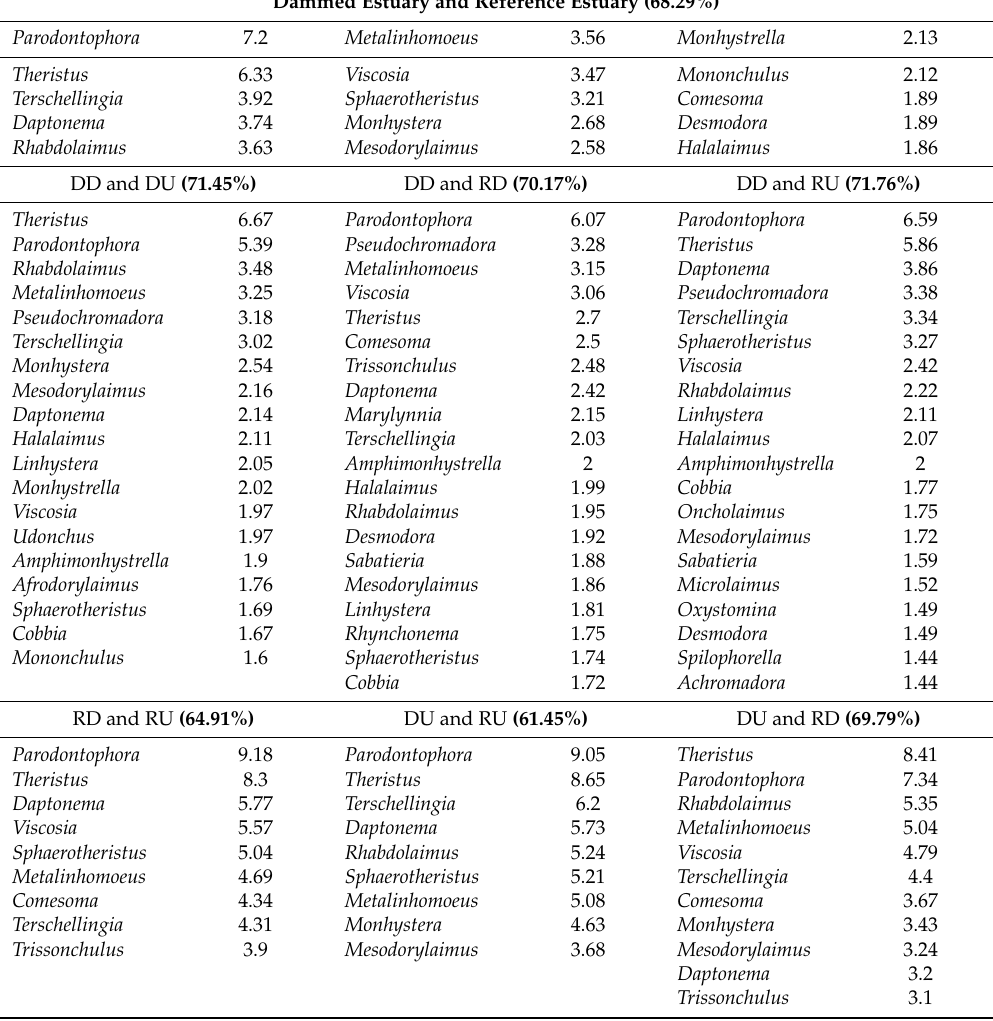
Table A1. The percentage of contribution of most important genera responsible for dissimilarity in relative abundance between groups based. Percentage dissimilarity (bold) between group (between the two estuaries and between each pair estuarine sections) and contributing percentage of each contributor for the dissimilarity between groups are shown together. Abbreviations: “DD” = dammed downstream, “DU” = dammed upstream, “RD” = reference downstream, “RU” = reference